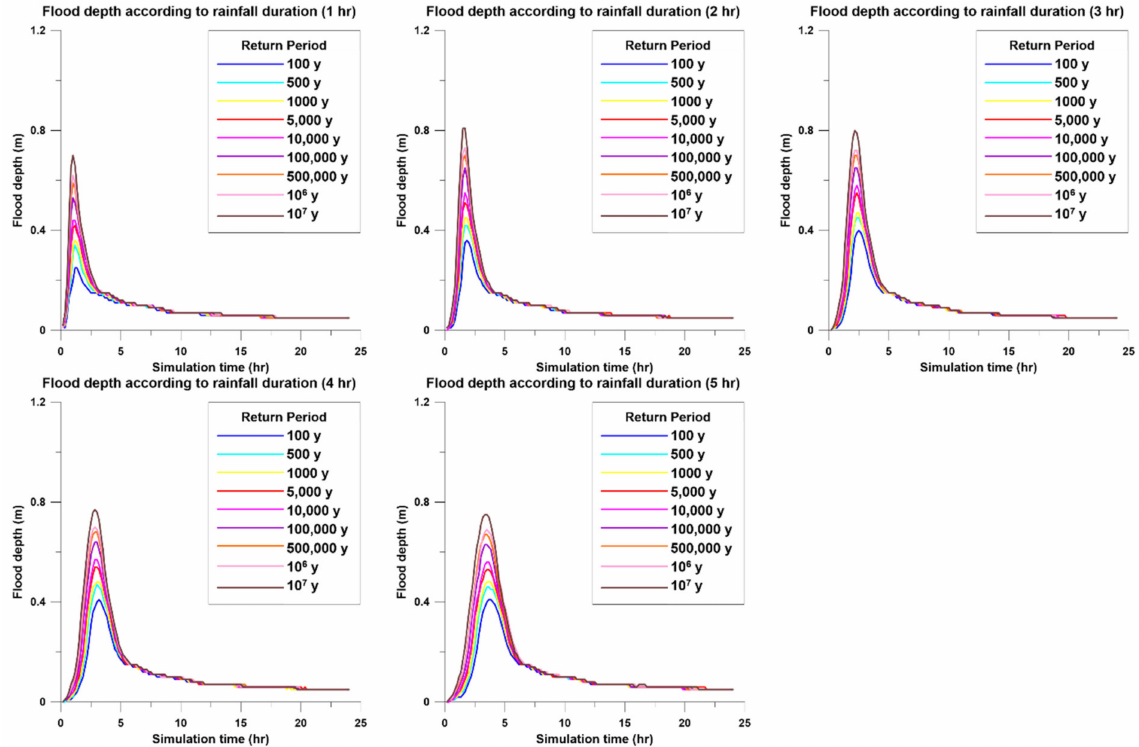
Figure 5. Inflow boundary conditions for grid no. 6792 (turbine building, NPP